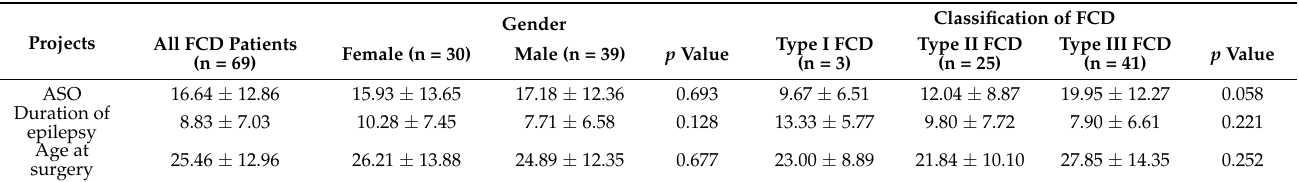
Table 1. Demographic characteristics of patients, (ASO: age of seizure onset).